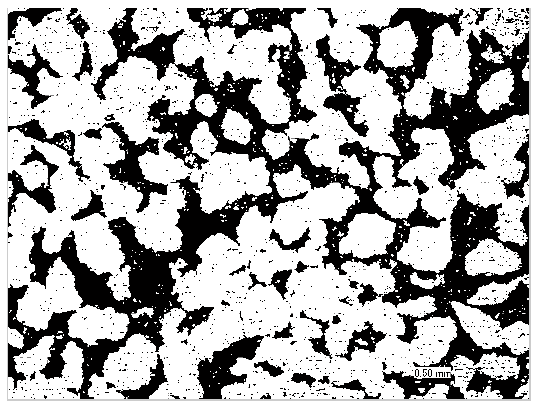
Table 2. Characteristics of porous titanium samples. Figure 3. Image analysis of surface topography (QSTU threshold segmentation which was proposed by the Japanese scholar named Otsu (Nobuyuki Otsu) in 1979).